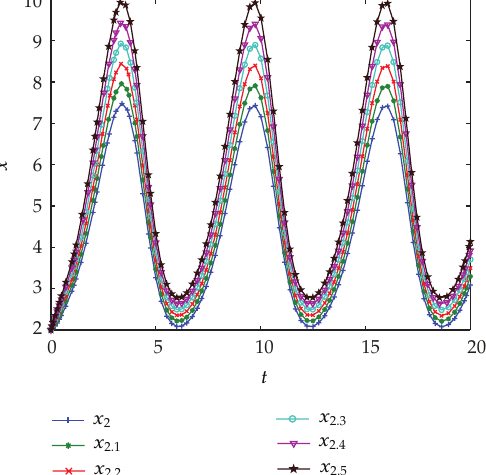
Figure 2: The graphs of x λ with di ff erent λ